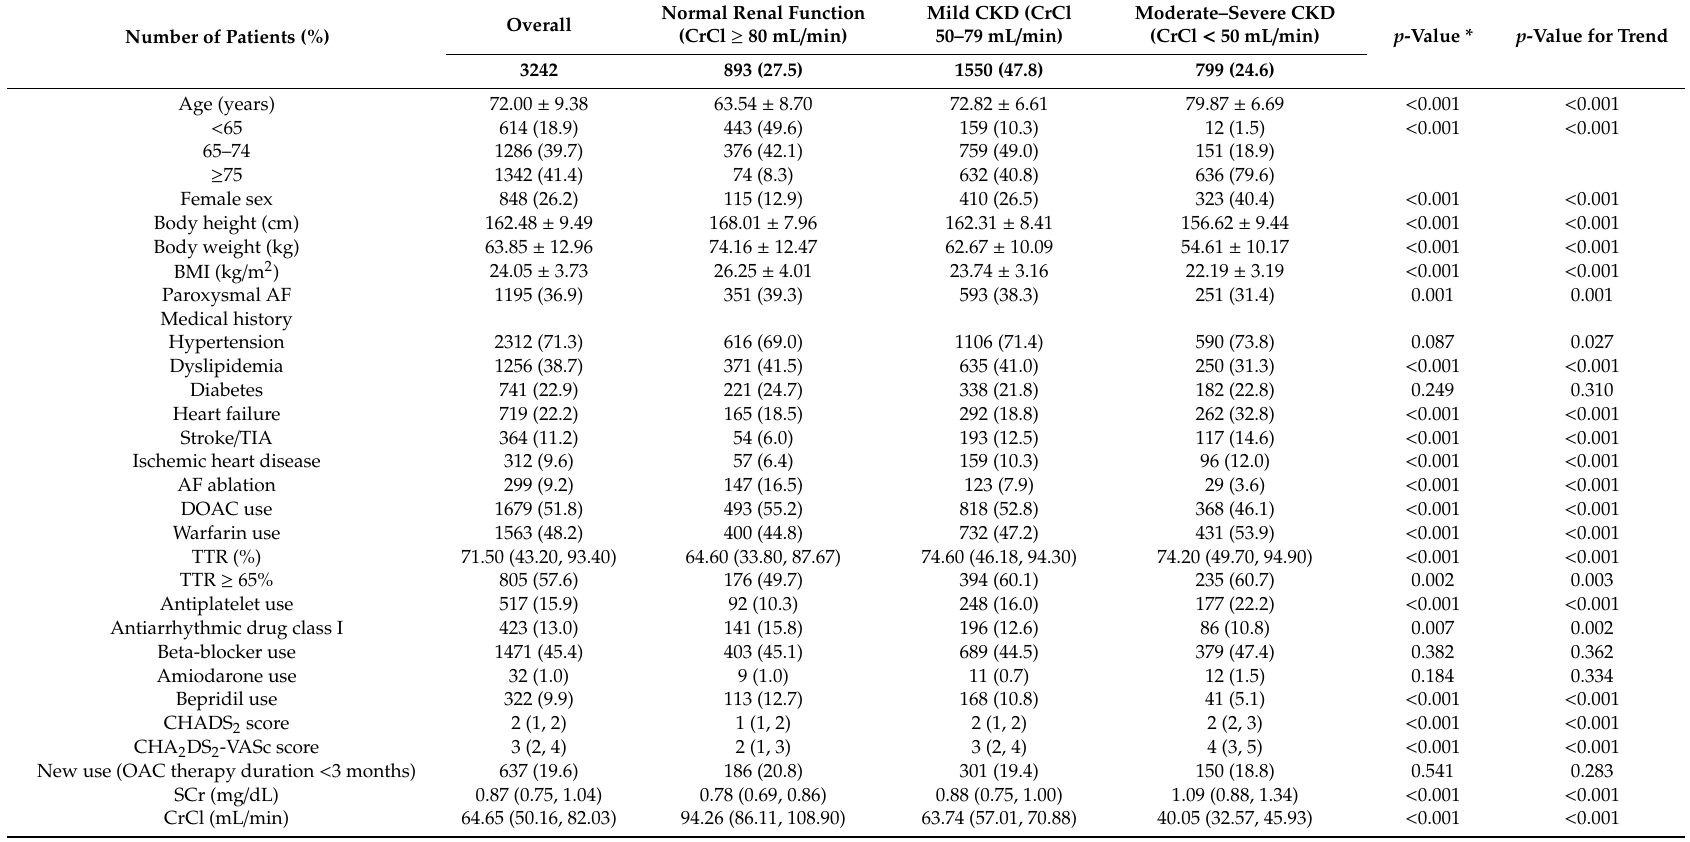
Table 1. Patient characteristics according to the renal